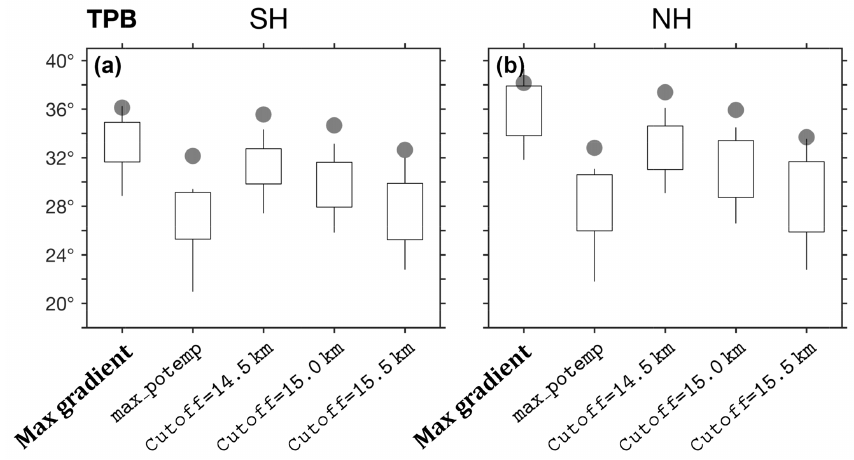
Figure 13. The mean latitude for the max_gradient , max_potemp , and cutoff methods of the TPB metric, as in Fig. 12a, b. For the cutoff method, geopotential height cutoff values of 14500, 15000 (default), and 15500m are shown. For Cutoff = 15500 and for max_potemp , three of the models produced unrealistic results and were removed from the